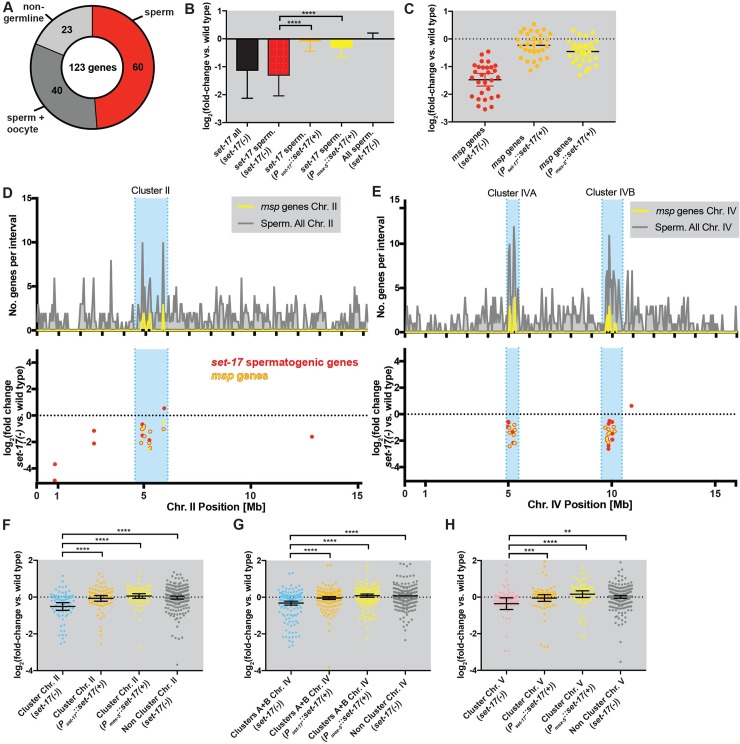
set-17 promotes expression of msp genes in spermatogenic gene clusters.A) Expression categories defined by Ortiz et al. (2014) of 123 transcripts misregulated in set-17 mutants based on RNAseq studies of whole L4 hermaphrodites. Sperm, enriched in sperm-producing germlines (60, red); sperm + oocyte, genes expressed similarly in sperm and oocytes (40, dark grey); non-germline, genes not detected in dissected germlines (23, light grey). We did not detect genes enriched in oocytes but not sperm. B) set-17 promotes expression of a subset of spermatogenic transcripts. Average log2-fold change in expression vs. the wild-type for all 123 set-17 misregulated transcripts (set-17 all) in set-17 mutants; for the 60 set-17 misregulated spermatogenic transcripts (set-17 sperm.) in set-17 mutants, in set-17; Pset-17::set-17(+) and in set-17; Pmex-5::set-17(+) mutants, respectively; and for all 2,306 previously identified spermatogenic transcripts (All sperm.) in set-17 mutants. **** P < 0.0001, MW exact or KS test. C) set-17 promotes msp expression in the germline. log2-fold change in expression vs. the wild type for all 28 msp gene transcripts (msp genes) in set-17, set-17; Pset-17::set-17(+) and set-17; Pmex-5::set-17(+) mutants. **** P < 0.0001, MW exact or KS test. D), E) set-17 spermatogenic genes cluster in the genome. Positional distributions of spermatogenic genes and msp genes on chromosomes II and IV and spermatogenic set-17-misregulated genes on chromosomes II and IV. Above: histograms of spermatogenic genes on chromosomes (D) II and (E) IV. Blue, spermatogenic gene clusters. Below: log2-fold change in expression in set-17 vs. the wild type from RNAseq studies in whole L4 hermaphrodites for the set-17 spermatogenic genes (red) on chromosomes (D) II and (E) IV. Yellow, msp genes. F) set-17 promotes expression of spermatogenic genes in a cluster on chromosome II. log2-fold change in expression vs. wild type from RNAseq studies of whole L4 hermaphrodites for all spermatogenic genes in the spermatogenic gene cluster on chromosome II (blue region in 5D) in set-17 (blue), set-17; Pset-17::set-17(+) (orange) and set-17; Pmex-5::set-17(+) (yellow) as well as for all spermatogenic genes outside of the blue region on chromosome II (grey). Mean +\-95% CI; **** P < 0.0001, MW exact or KS test. G) set-17 promotes expression of spermatogenic genes in clusters on chromosome IV. log2-fold change in expression vs. the wild type from RNAseq studies of whole L4 hermaphrodites for all spermatogenic genes in the spermatogenic gene clusters on chromosome IV (blue regions in 5E) in set-17 (blue), set-17; Pset-17::set-17(+) (orange) and set-17; Pmex-5::set-17(+) (yellow), as well as for all spermatogenic genes outside of the blue region on chromosome IV (grey). Mean +\-95% CI; **** P < 0.0001, MW exact or KS test. H) set-17 promotes expression of spermatogenic genes in a cluster on chromosome V. log2-fold change in expression vs. the wild type from RNAseq studies of whole L4 hermaphrodites for all spermatogenic genes in the newly identified spermatogenic gene cluster on chromosome V (blue region in S5K) in set-17 (pink), set-17; Pset-17::set-17(+) (orange) and set-17; Pmex-5::set-17(+) (yellow) as well as for all spermatogenic genes outside of the blue region on chromosome V (grey). Mean +\-95% CI shown. Cl. V (set-17(-)) vs. Non-Cl. V (set-17(-)), ** P < 0.005, MW exact; Cl. V (set-17(-)) vs. Cl. V (Pset-17::set-17(+)), *** P < 0.0005, Wilcoxon test; Cl. V (set-17(-)) vs. Cl. V (Pmex-5::set-17(+)), **** P < 0.0001, Wilcoxon test.